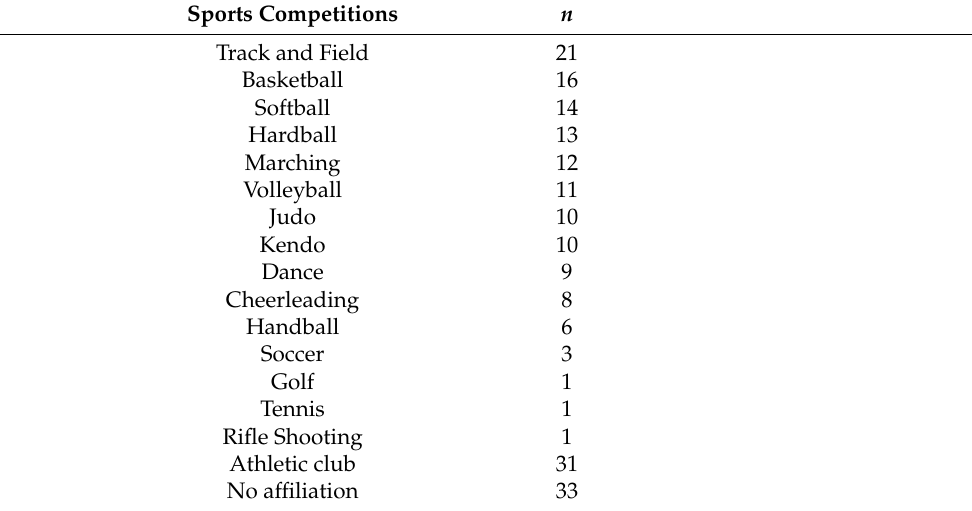
Table 2. Competition events of the